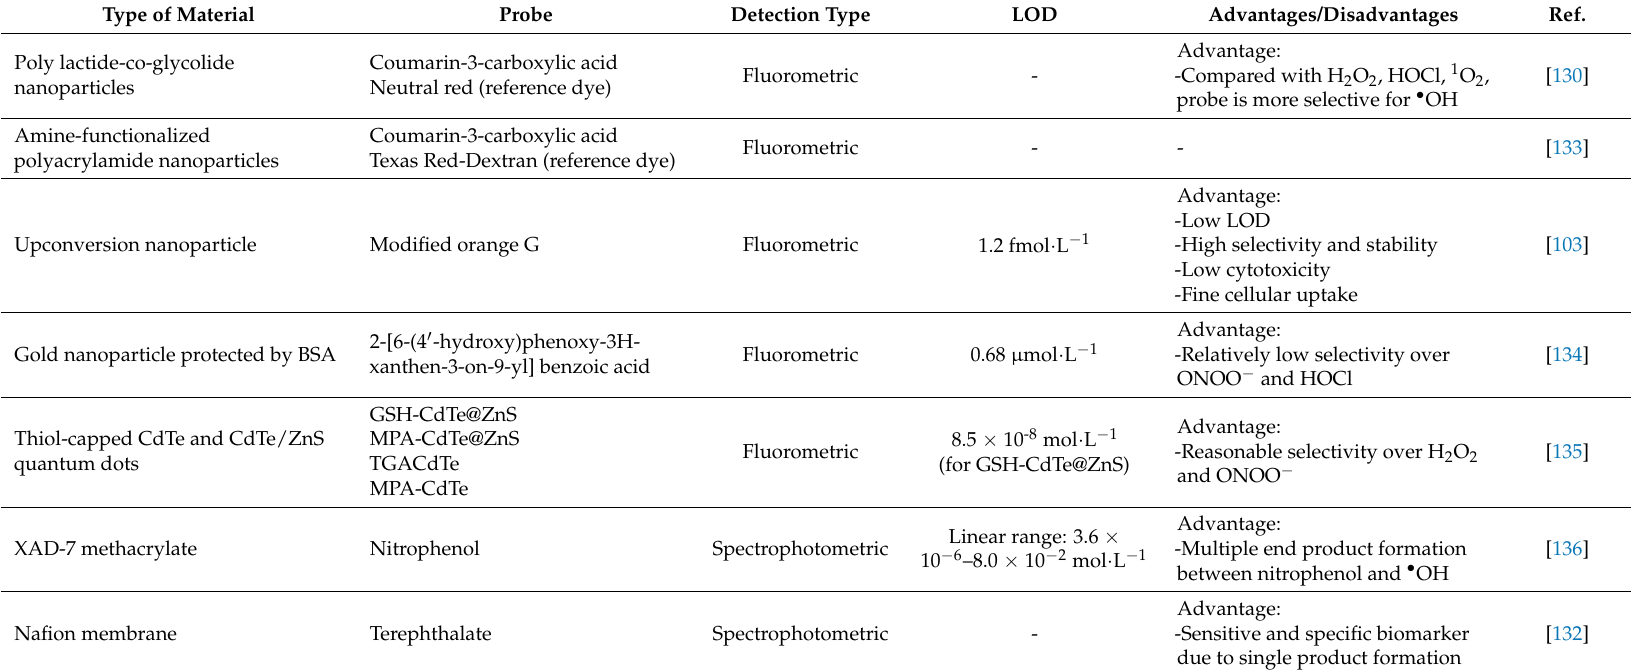
Table 6. Spectroscopic nanoprobes and sensors for detecting hydroxyl